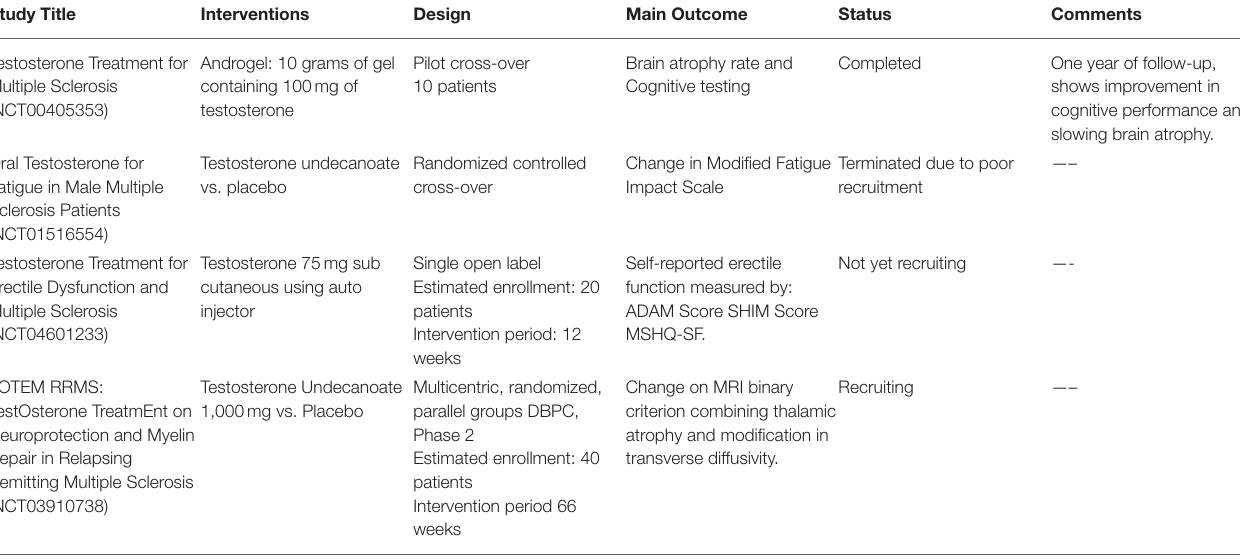
TABLE 2 | Main clinical trials using testosterone in